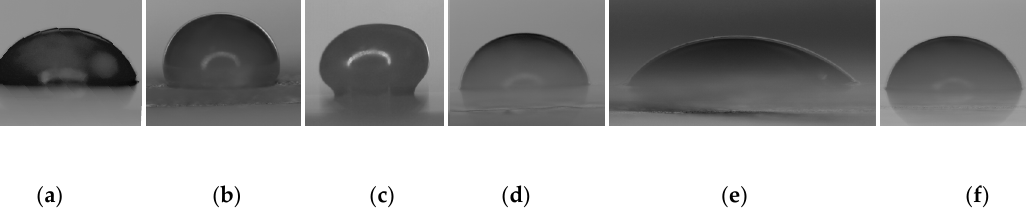
Figure 6. Wetting behaviour between ( a ) untreated, ( b ) mechanical blasted, ( c ) anodized, ( d ) phosphated, ( e ) adhesion promoted, and ( f ) etched AA6082 and melted PA6.